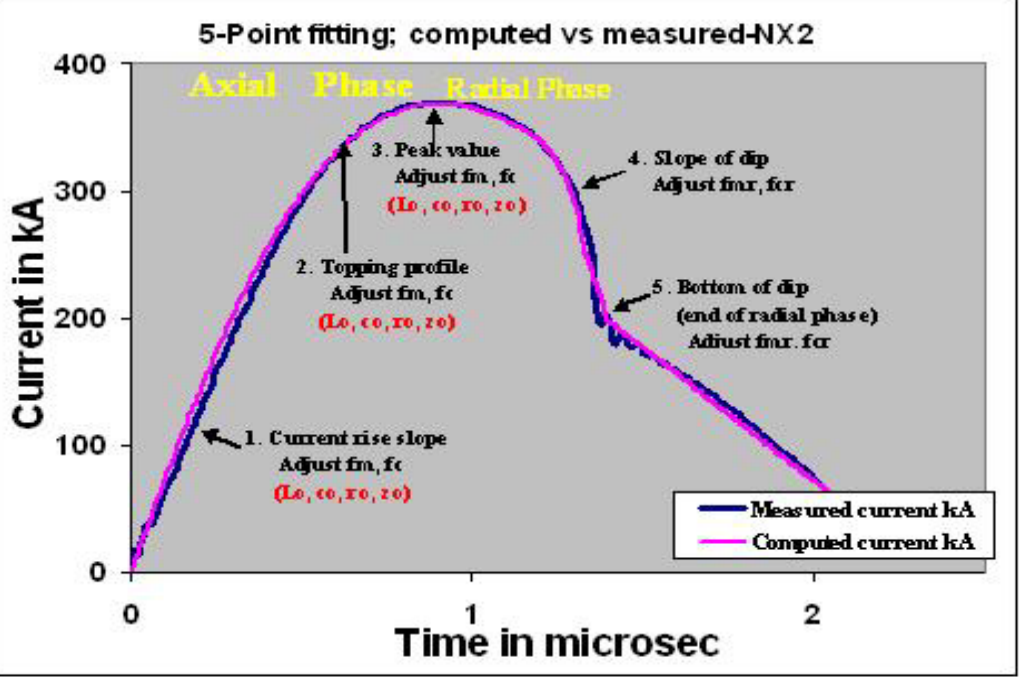
Figure 3. The 5-point fitting of computed current trace to the measured (or the reference) current trace. Point 1 is the current rise slope. Point 2 is the topping profile. Point 3 is the peak value of the current. Point 4 is the slope of the current dip. Point 5 is the bottom of the current dip. Fitting is done up to point 5 only. Further agreement or divergence of the computed trace with/from the measured trace is only incidental and not considered to be